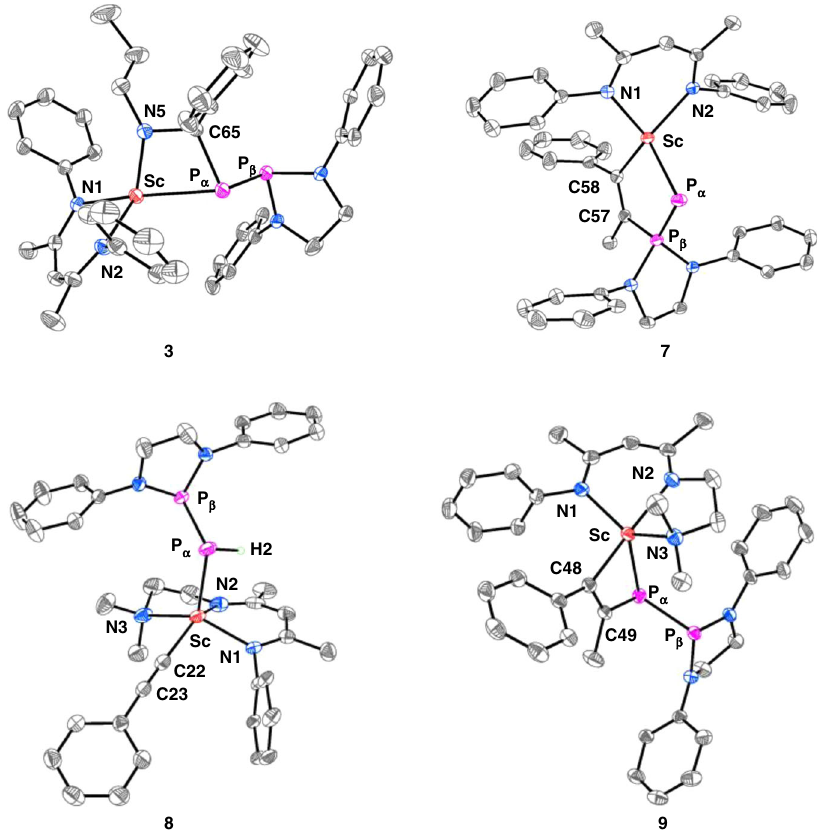
Fig. 4 Molecular structures of complexes 3 and 7 – 9. The ellipsoids of 3 are at 30% probability level, while those of 7 , 8 , and 9 are at 40% probability level. DIPP isopropyl groups and hydrogen atoms (except the hydrogen atom on P α in 8 ) were omitted for